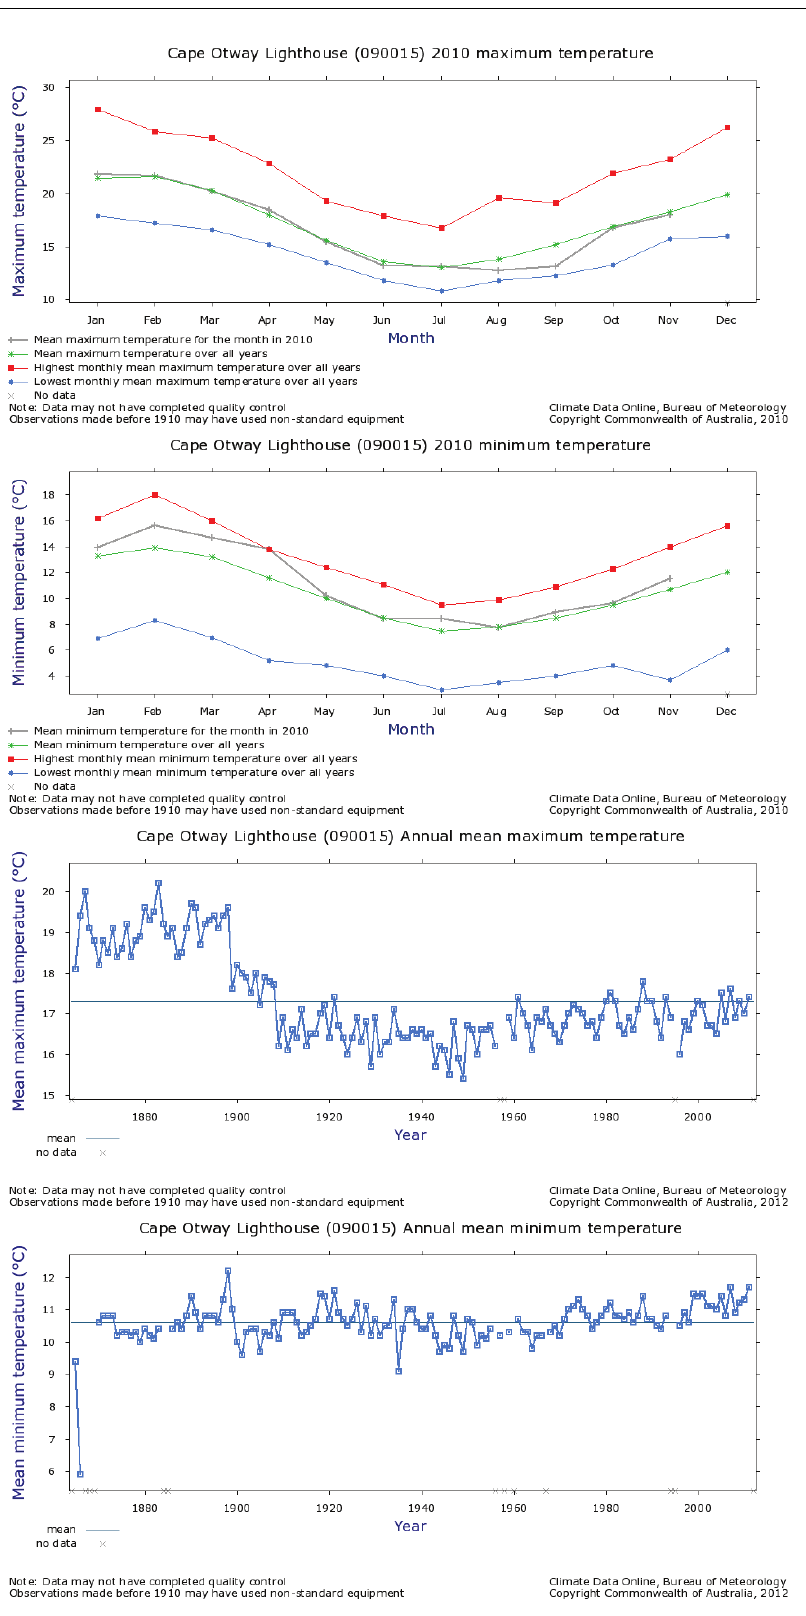
Figure 14. Australian Government Bureau of Meteorology temperature graphs for historical locations in Victoria, Aus-